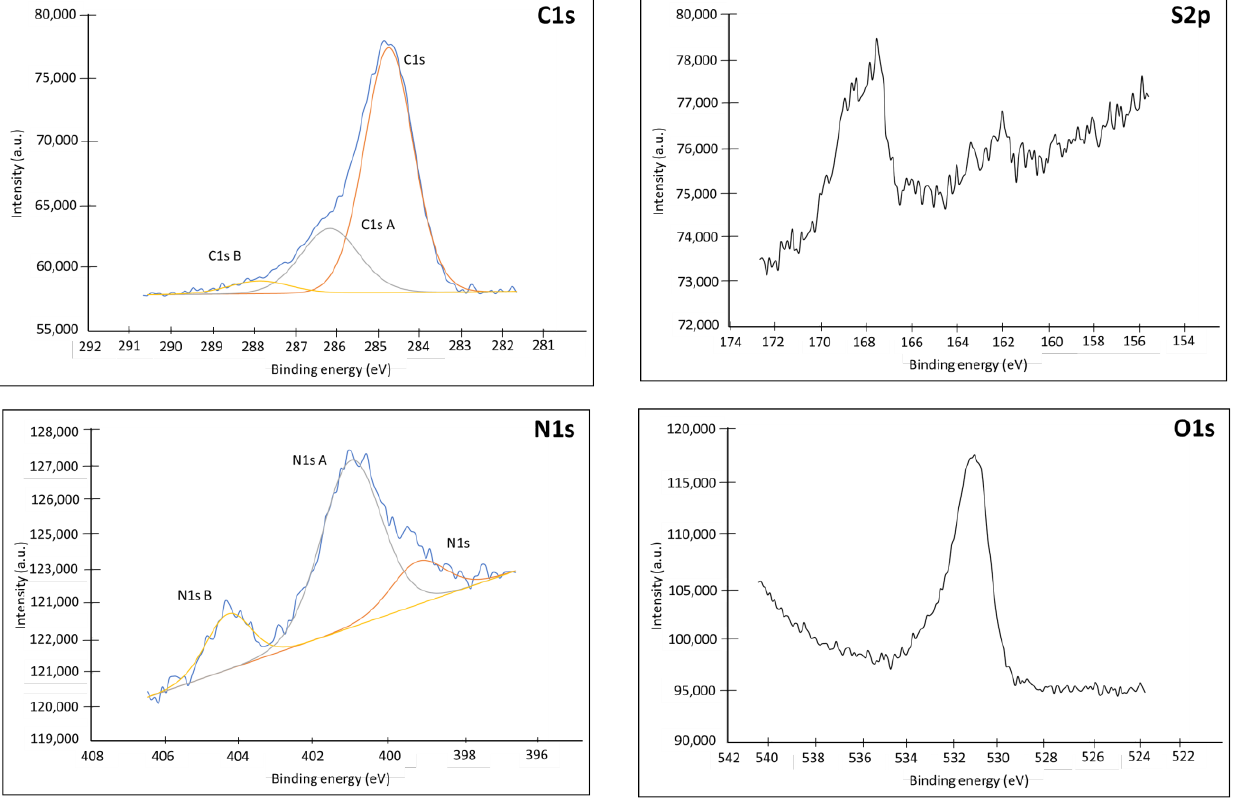
Figure A4. XPS spectra (C1s, S2p, N1s, O1s) of an Au plate electrode modified with 1-azido-6-thiohexane (Product 3).